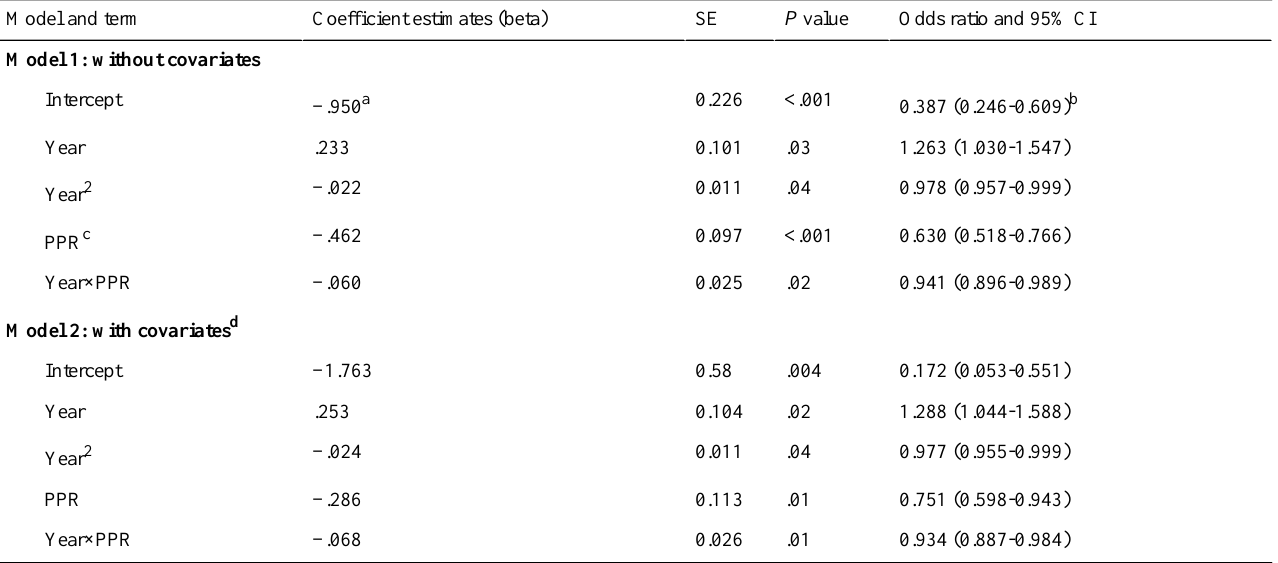
Table 2. Coefficients of multiple logistic regression models with and without covariates.